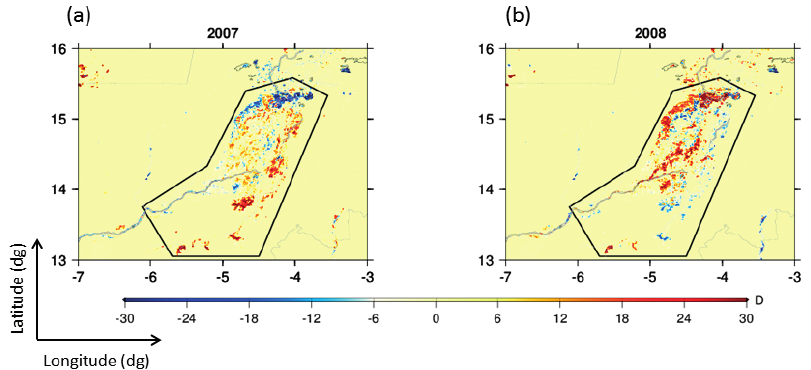
Figure 9. Yearly anomalies of duration (in day) of presence of open water for ( a ) 2007 and ( b )